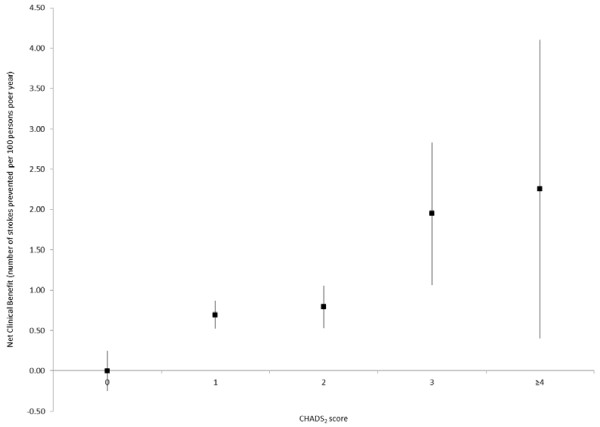
 Net clinical benefit of warfarin, stratified according to CHADS2score at baseline (based on an ICH weight of 1.5).